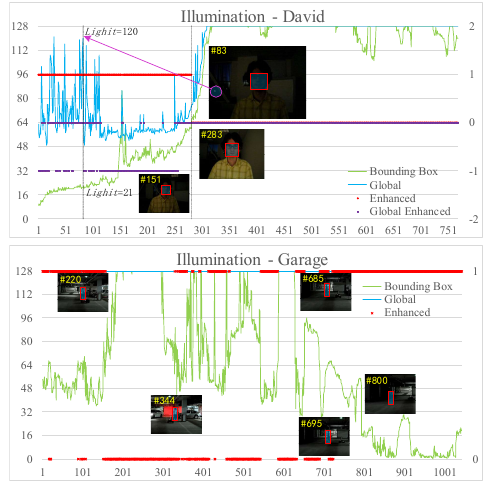
Figure 9. Comparison of global and BB illumination. The top figure shows the luminance values of the David sequence, and the following is the Garage sequence. The BB and global illumination increase over time in the David sequence. However, in the Garage sequence, the global brightness is always the maximum because of the lamp on the right.